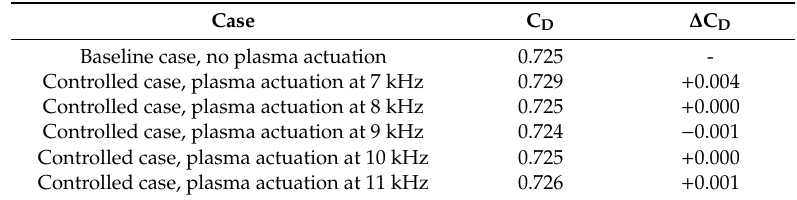
Table 1. Coe ffi cient of drag of the model with and without Alternate Current Dielectric Barrier Discharge (AC-DBD) plasma actuation.